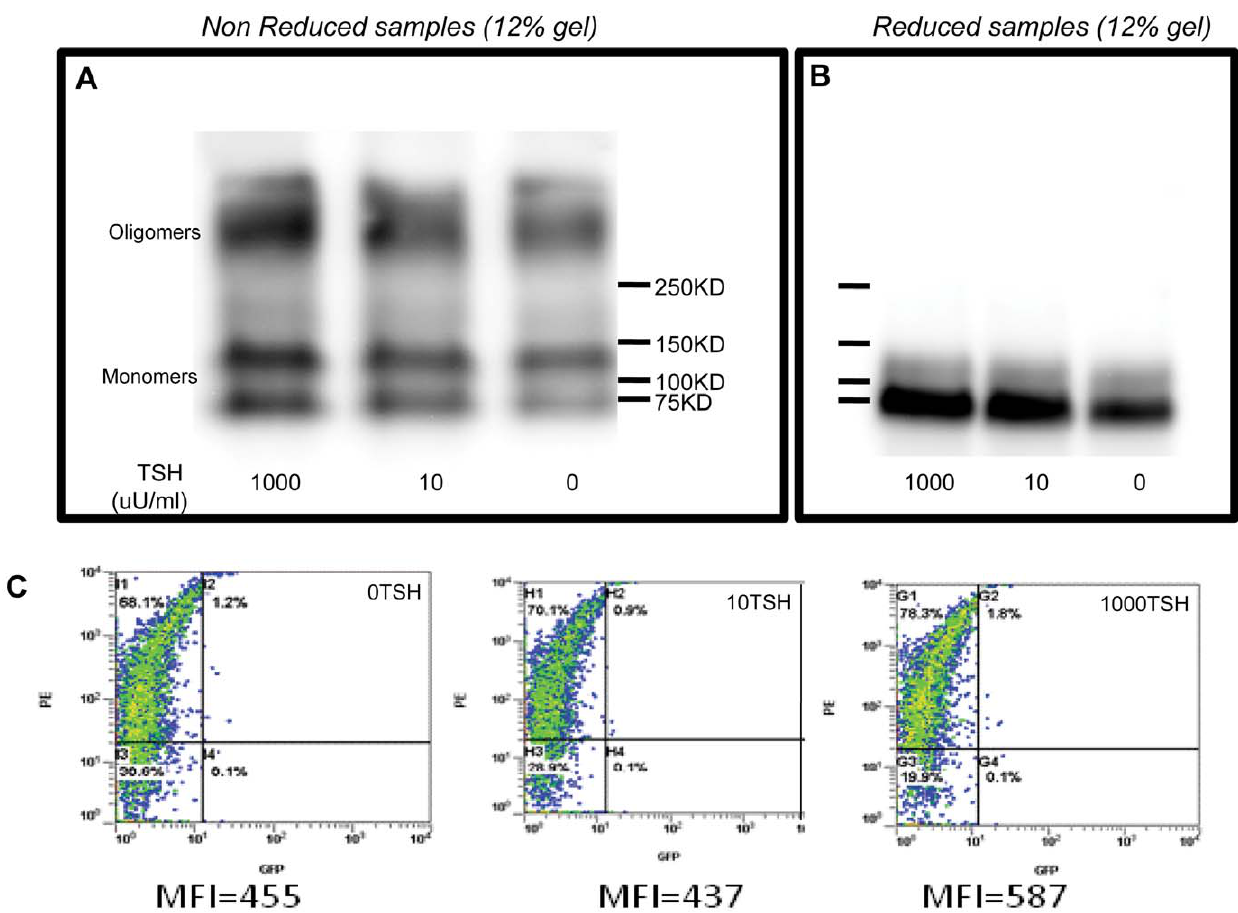
Figure 3. Immunoblot of total membranes under reduced and non-reduced conditions from transiently transfected HEK cells: HEK 293 cells transiently transfected with HA-GPI-TSHR-ecd were treated with 0, 10 and 1000 m U/ml of bovine TSH for 1 hr at 37 u C. Total membranes prepared from untreated and treated cells were divided into 30 m g/lane and treated with 5X sample buffer containing reducing agent ( + DTT:100 mM DTT final) and non-reducing agent (-DTT) and the proteins separated by 12% SDS-PAGE. The blots were probed further using 2 m g/ml TSHR antibody M4 (epitope 322–341) followed by detection with anti-mouse HRP (1:20,000) and developed using pico SuperSignal ECL (Pierce Ltd). Panel A ) Shows the untreated and TSH treated samples under non-reduced conditions. Panel B ) The same set of samples as in Panel A after reduction with DTT for 45minutes at 50 u C. Results are similar to that observed with stably expressed cells in Figure 2. Panel C ) Flow cytometric data of untreated versus treated cells. TSH treatment did not alter the expression profile of HA in these HA-GPI-TSHR-ecd transiently transfected cells. The expression levels of the tagged receptor are indicated by their mean fluorescence intensity (MFI).